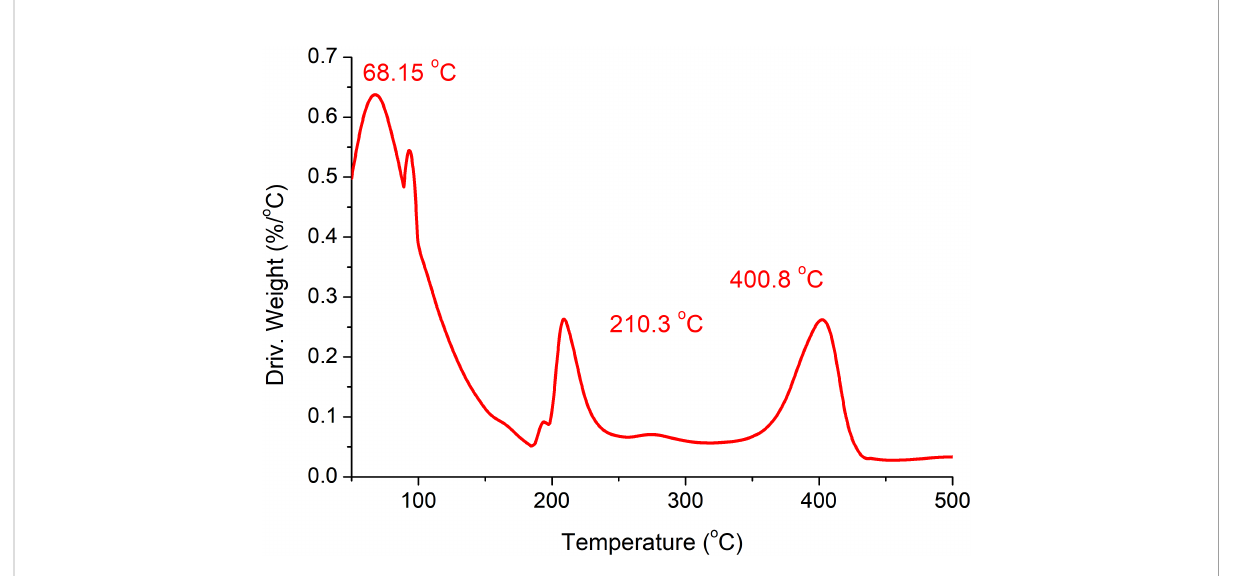
FIGURE 6 First-order weight derivative vs. temperature at a rate of